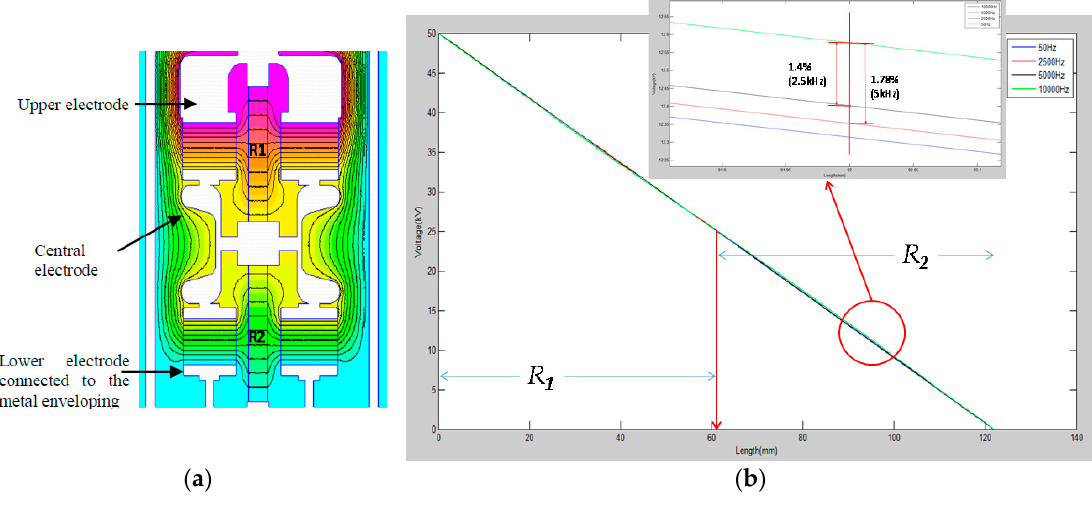
Figure 2. Voltage distribution: ( a ) Cut-away view of equipotential lines in the voltage divider; ( b ) voltage distribution along the two resistors of the HV branch for frequency range 50 Hz–5 kHz.